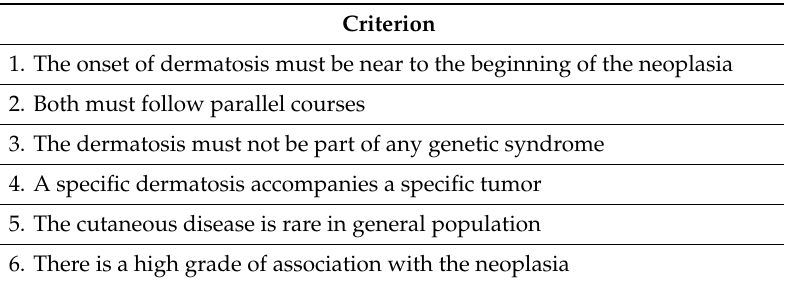
Table 1. Curth criteria for paraneoplastic dermatoses